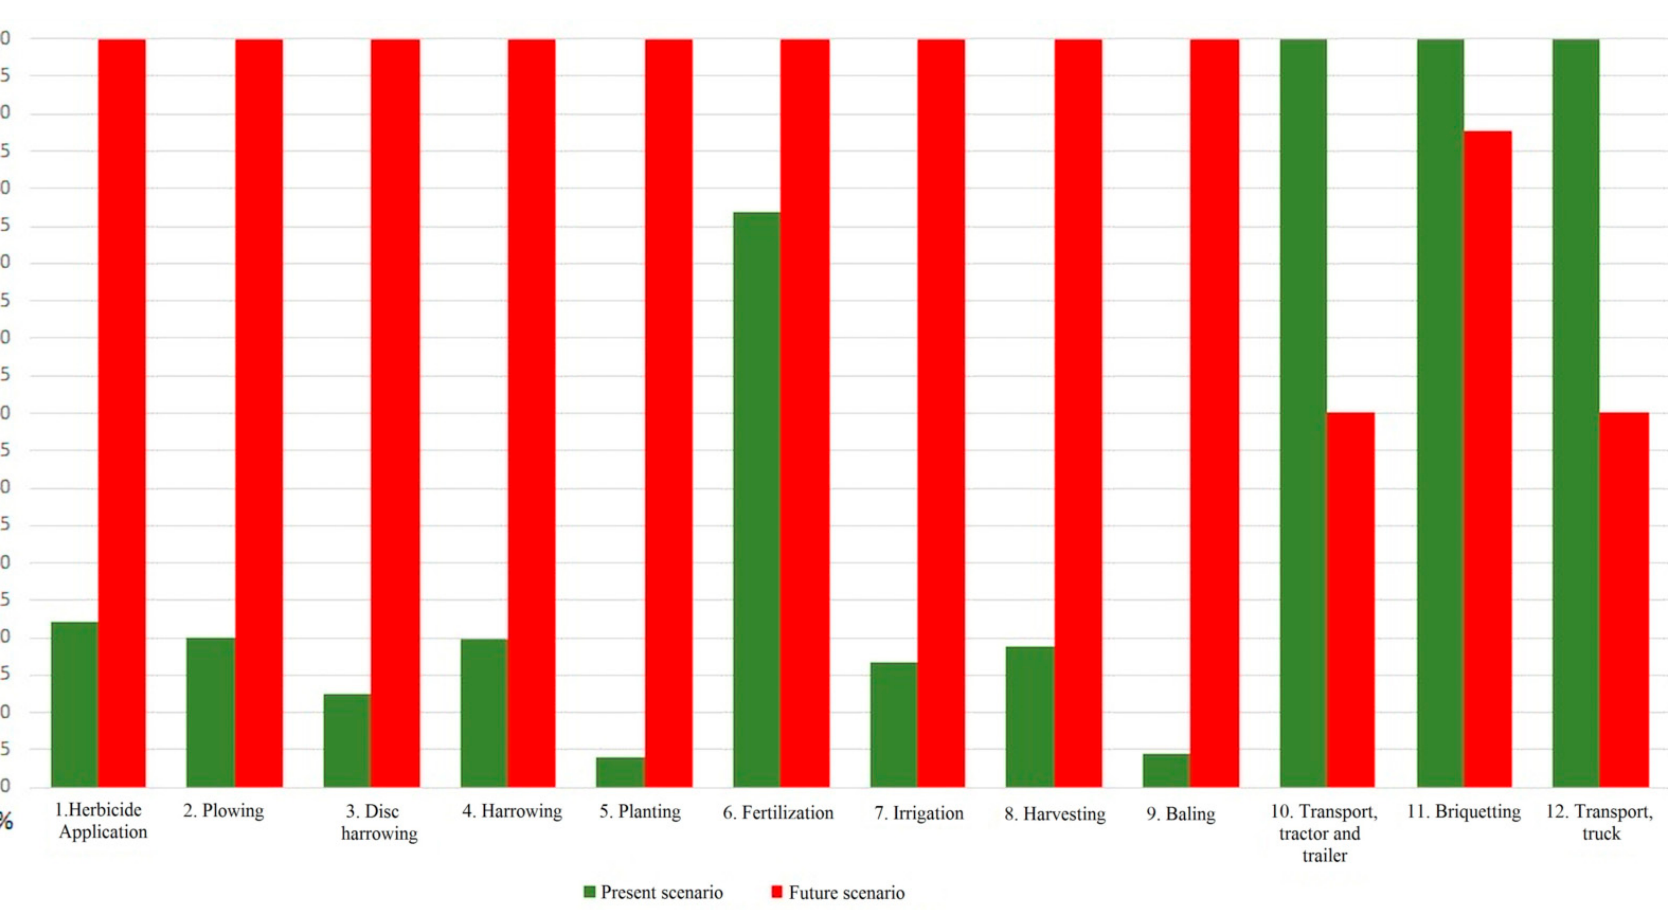
Figure 5. Comparison of climate change impacts from present and future scenarios of Miscanthus